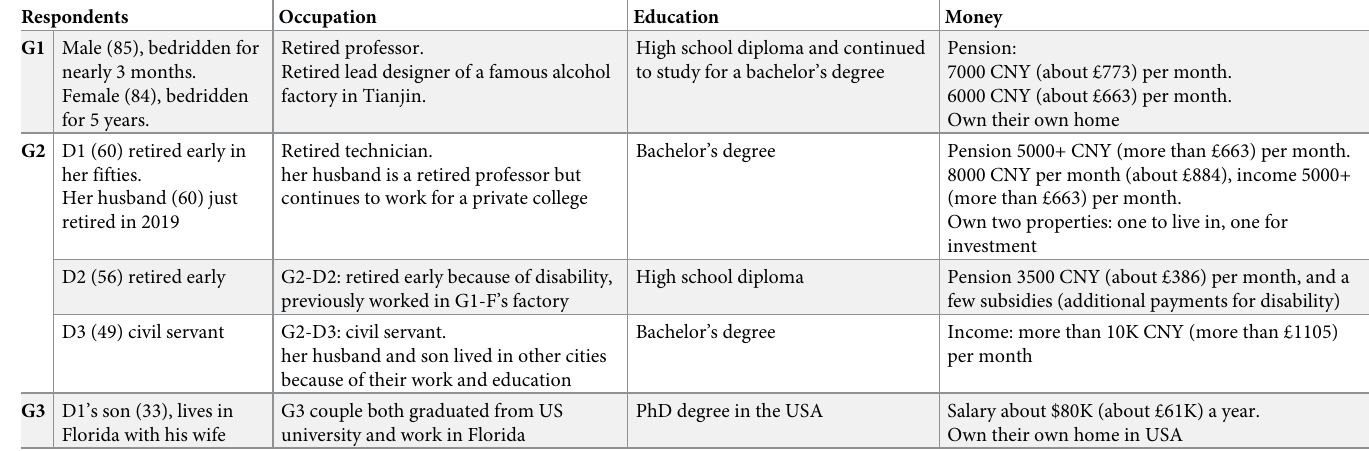
Table 3. The resource base of the Ye